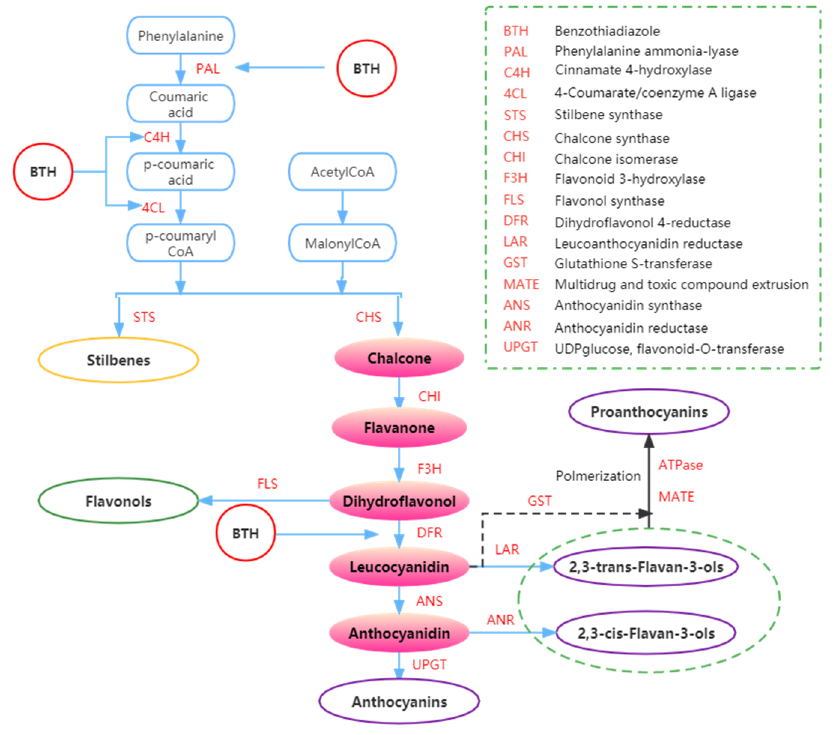
Figure 4. Summary of the effects of BTH on phenols metabolism. Adapted from Ruiz-García and Gómez-Plaza [43].